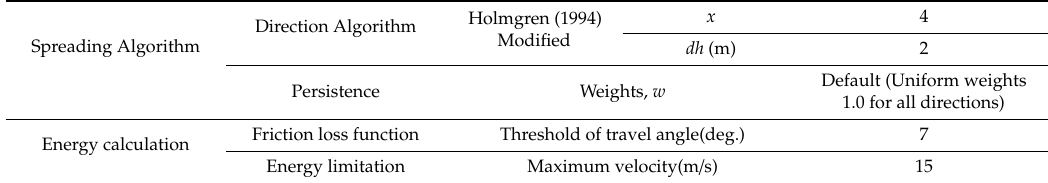
Table 3. Parameters and criteria used in Flow-R analysis.